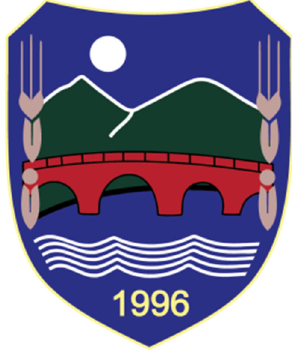
Figure 11. Arms with solar disk: Zhelino.